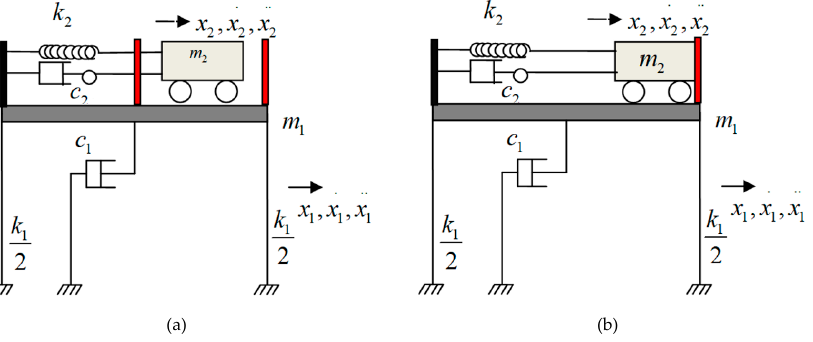
Figure 2. Schematic of ( a ) double-sided pounding tuned mass damper (PTMD); ( b ) single-sided